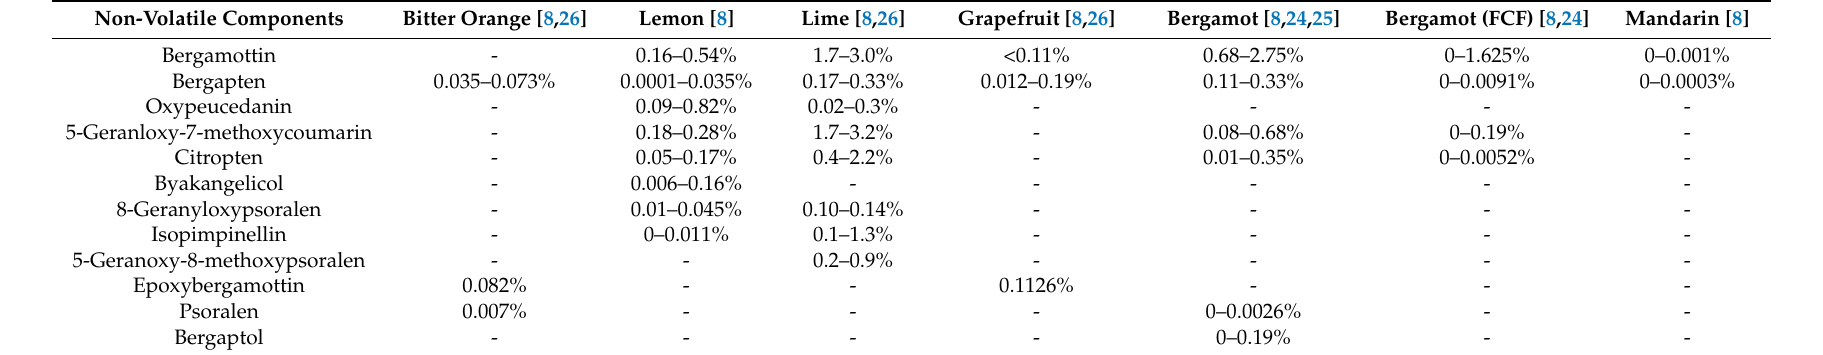
Table 2. Non-volatile components of some expressed Citrus